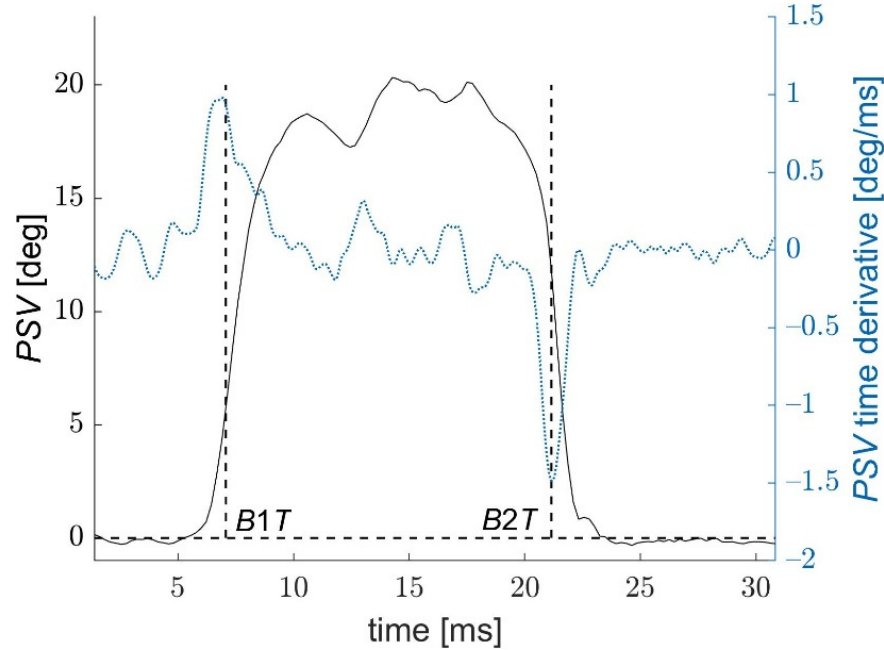
Figure 2. Local Profile Slope Variations for a corneal profile point per 240th column of the image sequences. B 1 T and B 2 T describe two times, when PSV achieve the fastest variations (values of the first time-derivative of PSV are extreme).